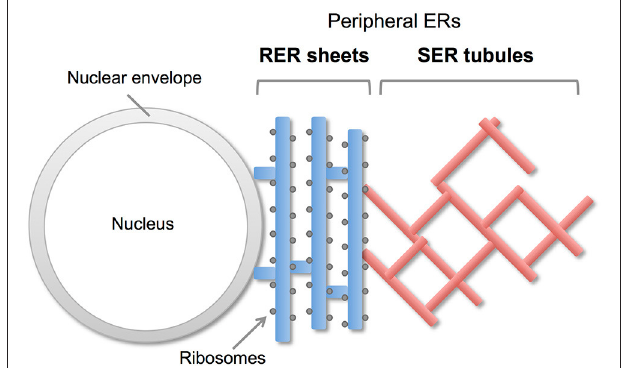
FIGURE 1 | Morphology of peripheral ERs in mammalian cells. The peripheral ERs are composed of two different subdomains; a ribosome-studded rough ER (RER) and a ribosome-free smooth ER (SER). The RERs form sheets in perinuclear region and play a role in protein synthesis and transport. The SERs form tubule networks in cytoplasm and are involved in lipids synthesis, calcium storage and detoxification.